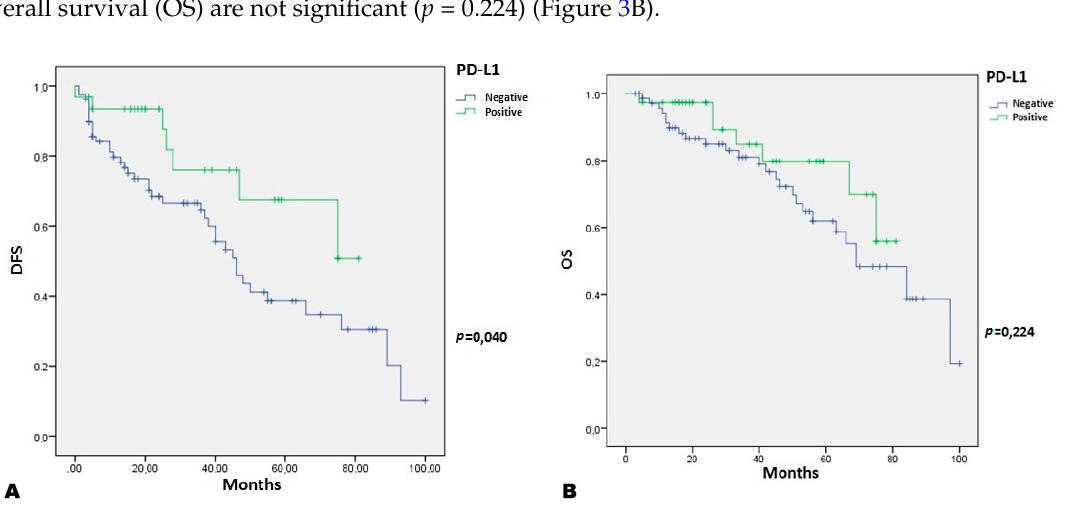
Figure 3. Tumor PD-L1 + TNBC patients Kaplan–Meier curves: ( A ) Disease Free Survival (DFS) ( p = 0.040); and ( B ) Overall Survival (OS) ( p =